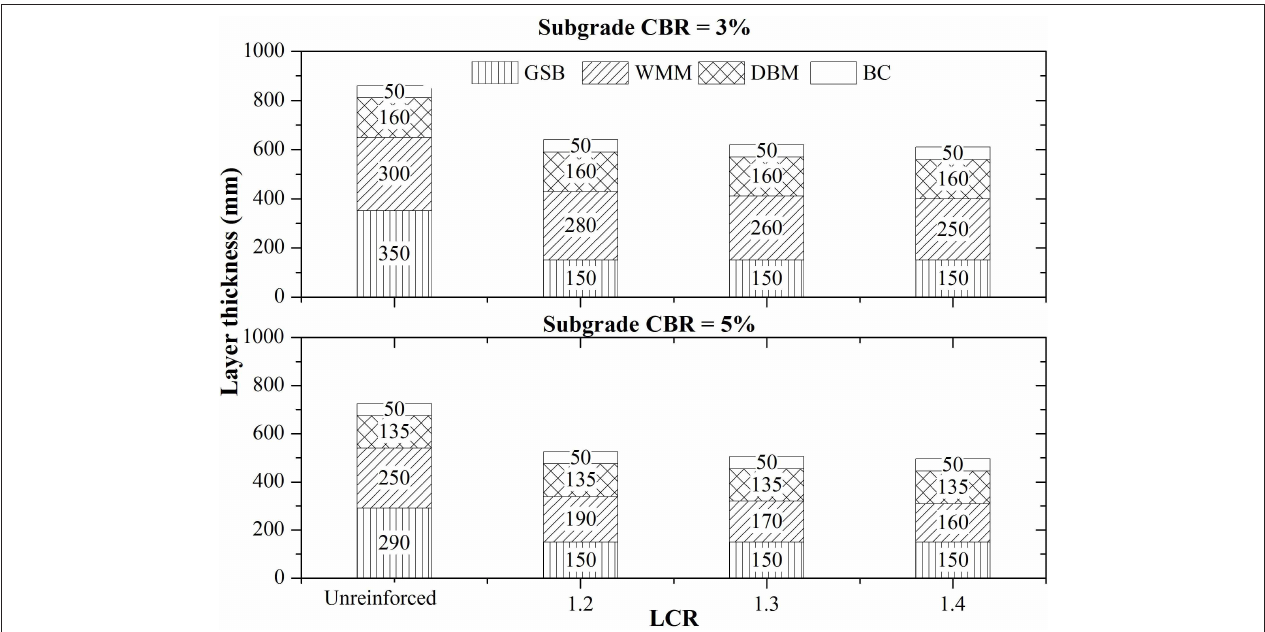
FIGURE 2 | Design charts showing thicknesses of unreinforced and geogrid reinforced flexible pavements using LCR approach based on Objective-1 for the traffic of 100 MSA with subgrade CBRs equal to 3 and 5%.